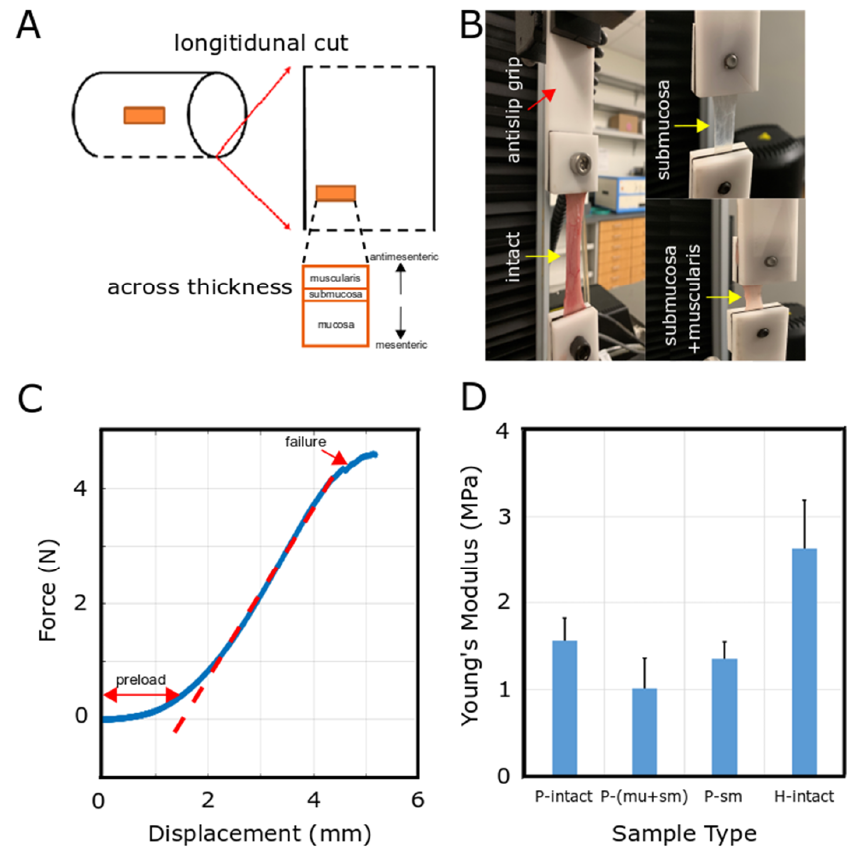
Figure 4. Mechanical characterization of pig and human small intestinal tissue. ( A ) Schematic diagram represents how rectangular specimens were prepared from cylindrical small intestinal tract. ( B ) Tensile test performed using an Instron type 5565 with anti-slip grips. ( C ) Representative force-displacement plot of a specimen. ( D ) Average Young’s modulus for pig and human. Sample numbers are n = 36, 27, 39, 31 for P-intact, P-(mu+sm), P-sm and H-intact, respectively, while subject (pig and human) numbers are n = 7, 5, 6, 7 for P-intact, P-(mu+sm), P-sm and H-intact, respectively.